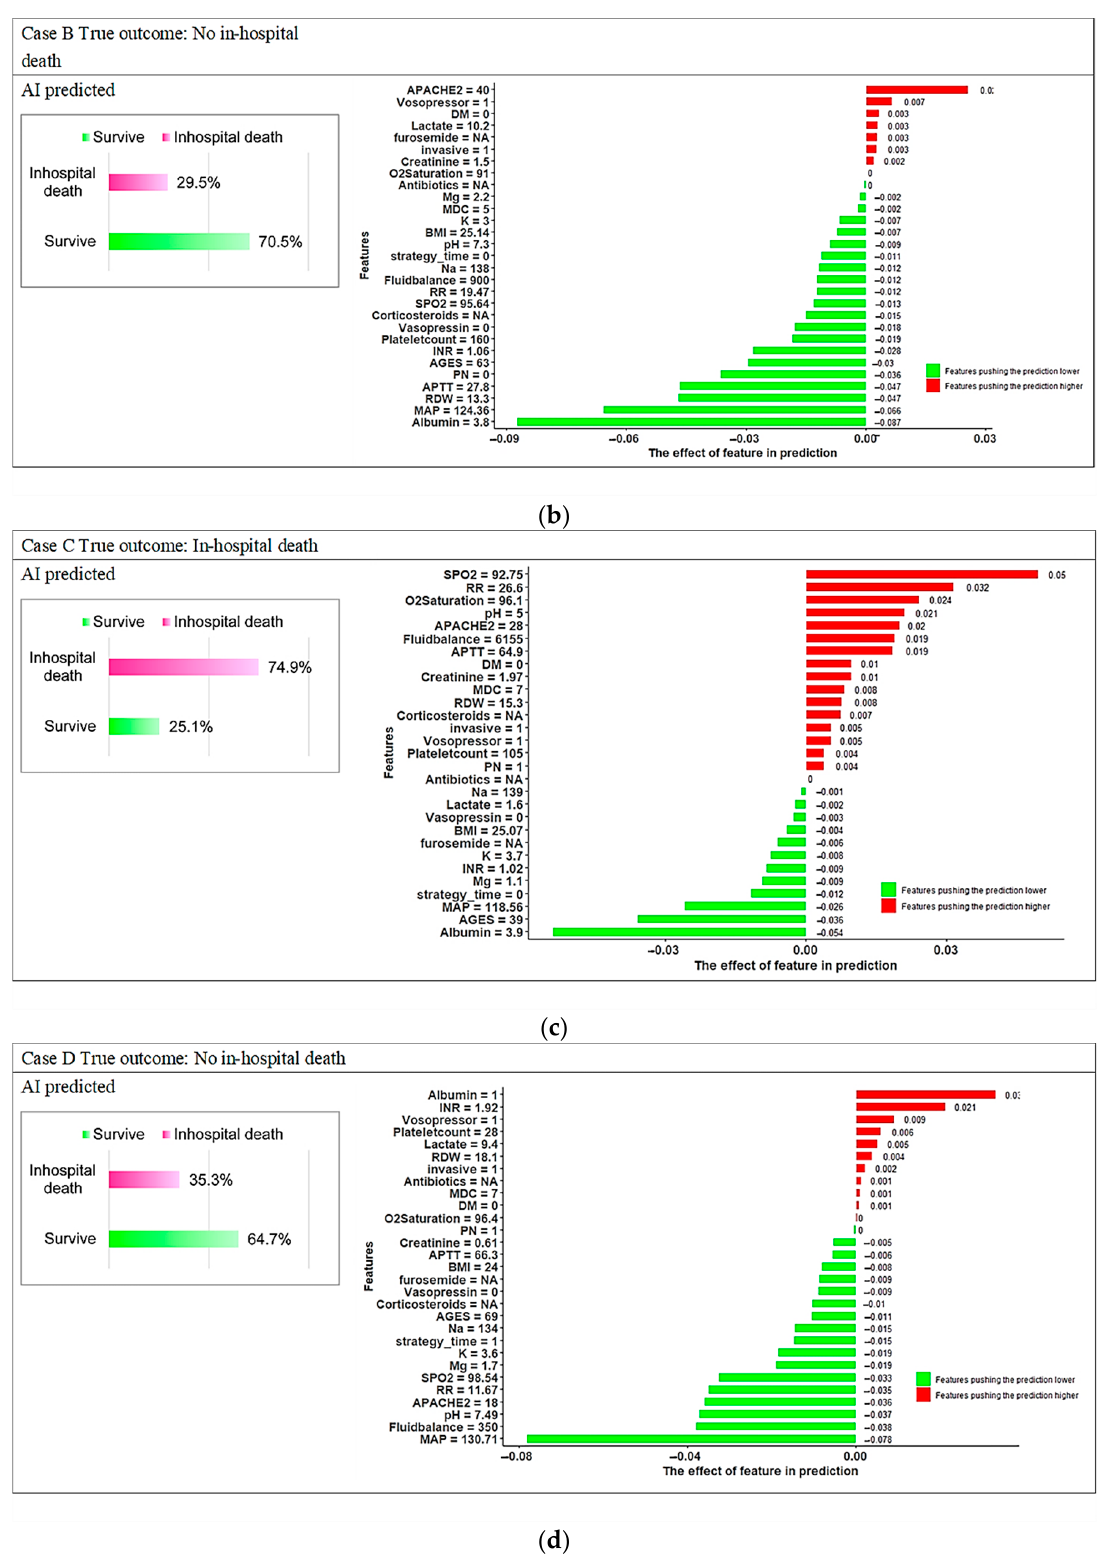
Figure A4. Local explanation plots for individuals with various in-hospital mortality statuses and random forest model predictions. ( a ) In-hospital death and AI predicted in-hospital death; ( b ) non-in-hospital death and AI predicted non-in-hospital death; ( c ) in-hospital death but AI predicted non-in-hospital death; ( d ) non-in-hospital death but AI predicted in-hospital death.